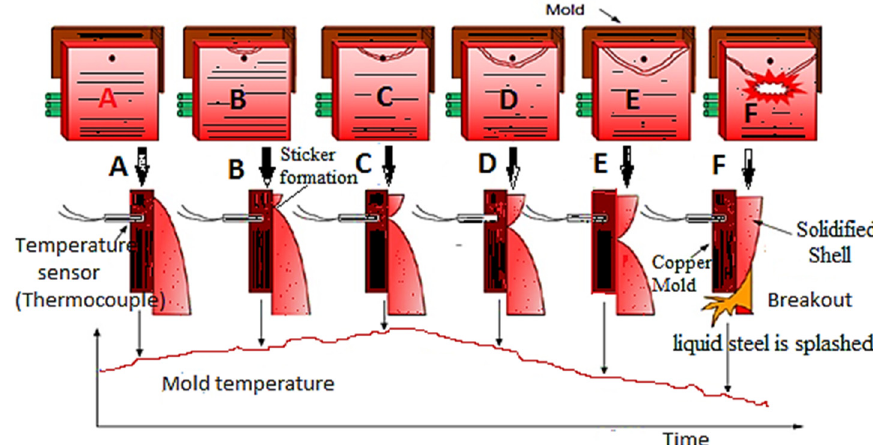
Figure 2. A schematic diagram of breakout.